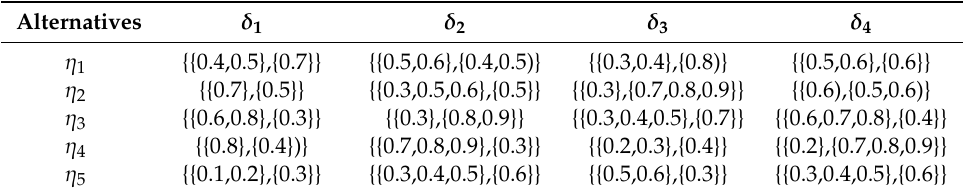
Table 1. Dual hesitant Pythagorean fuzzy decision